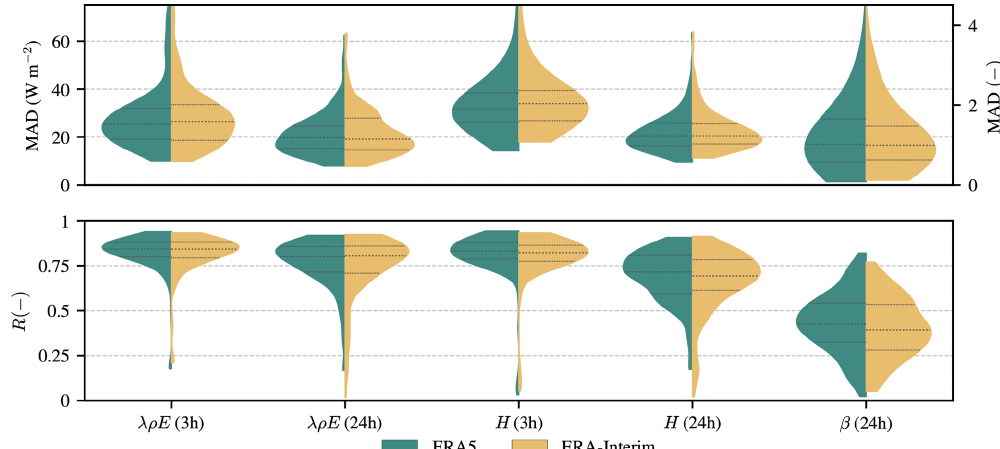
Figure A1. Violin plots of temporal validation statistics of the surface latent heat flux ( λρE ), surface sensible heat flux ( H ), and Bowen ratio ( β ) from ERA5 (green) and ERA-I (yellow). Statistics are calculated against in situ eddy-covariance measurements at both 3-hourly and daily temporal resolutions. Violin plots represent the distribution of the individual validation statistics with indication of the median and interquartile range and are calculated using a kernel density estimation approach. Statistics include the MAD (raw in situ time series from 143 sites as reference) and R (raw in situ time series from 143 sites as reference). The distribution of the MAD of β is plotted on the right y axis.